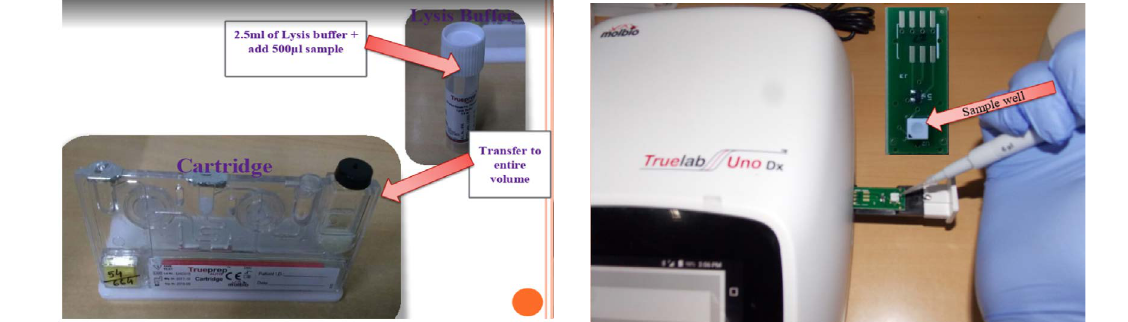
Fig. 1 DNA extraction process Fig. 2 . Loading of the chip with elute DNA